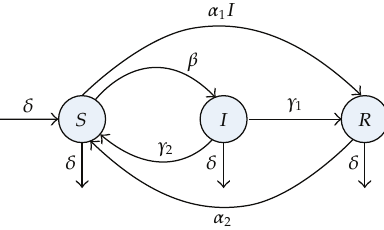
Figure 1: The transfer diagram of the SIRS